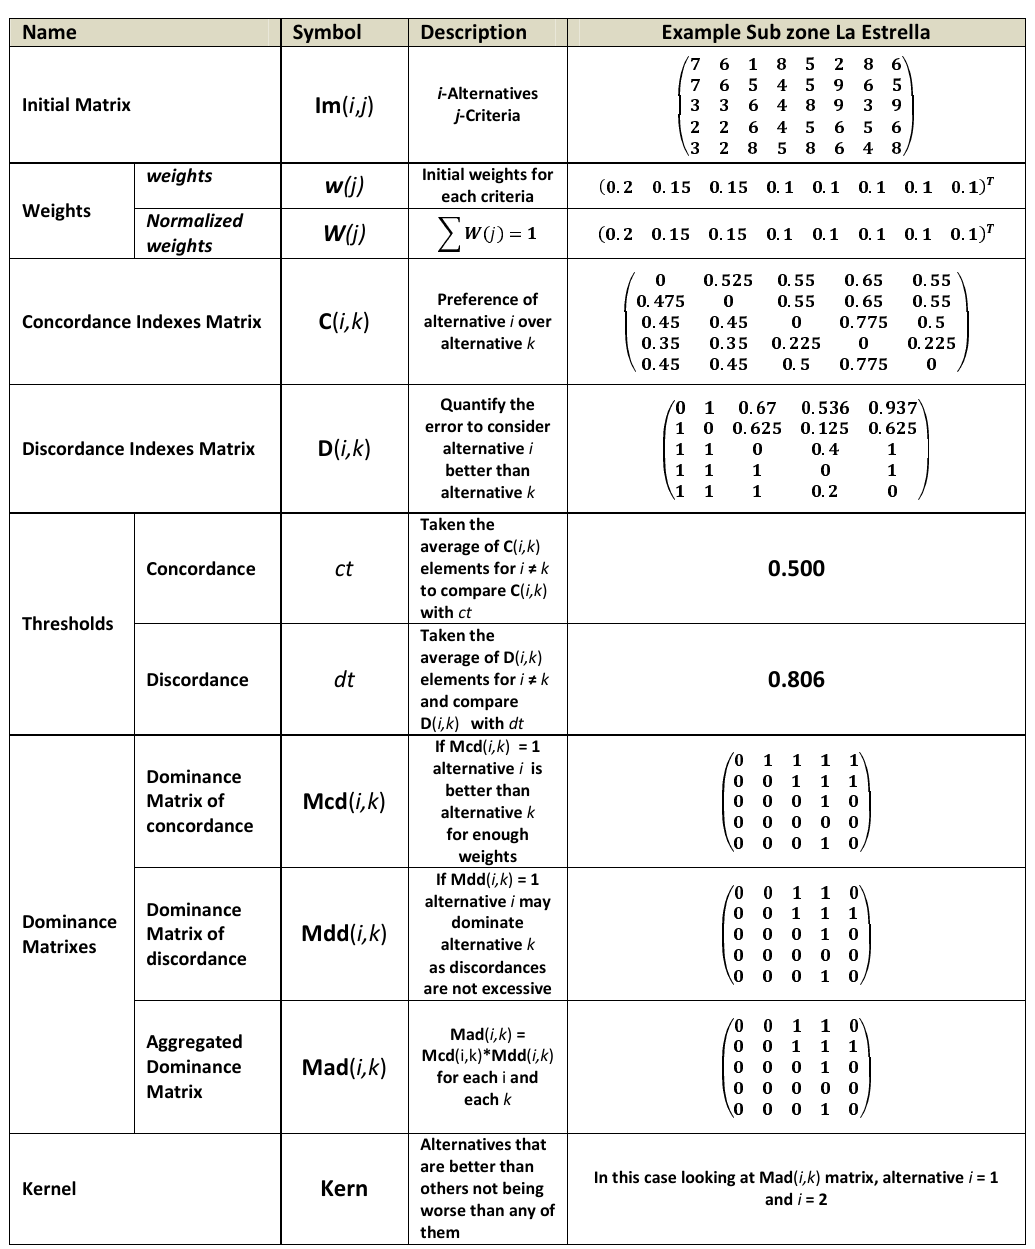
Fig. 3. Mathematical elements of erosion and desertification integral control plan using ELECTRE-I.